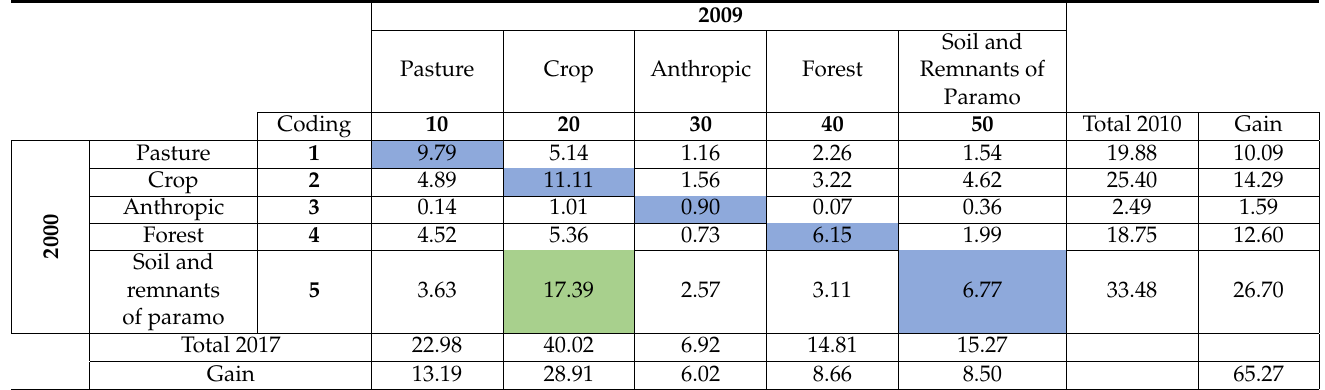
Table 4. Cross tabulation matrix with values expressed in percentages